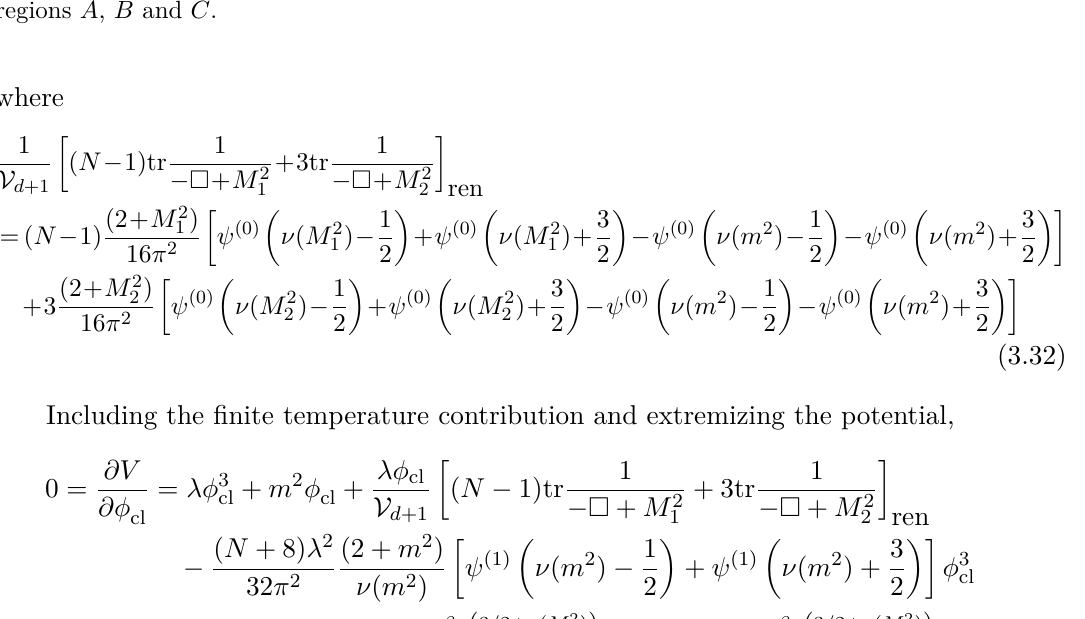
Figure 3. Phases and potentials for λ = 0 . 1 , N = 2 and n = 20 . The potential plots are shown for regions A , B and C